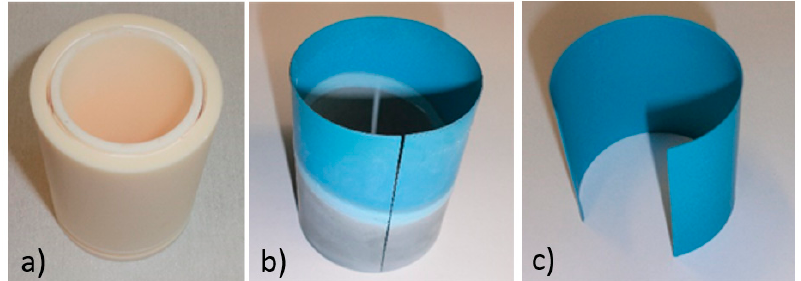
Figure 7. Form-assisted-sintering: ( a ) mold with matching inlay; ( b ) sintering results after use of a standard profile; ( c ) successful sintering achieved by extending the debinding time.